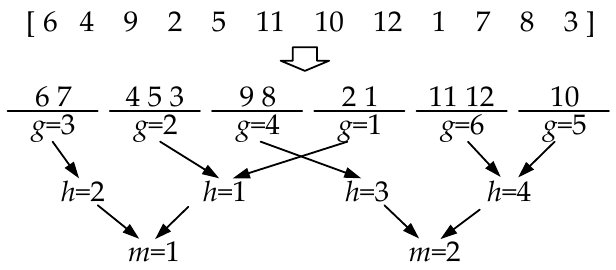
Figure 4. Diagram of decoding process.